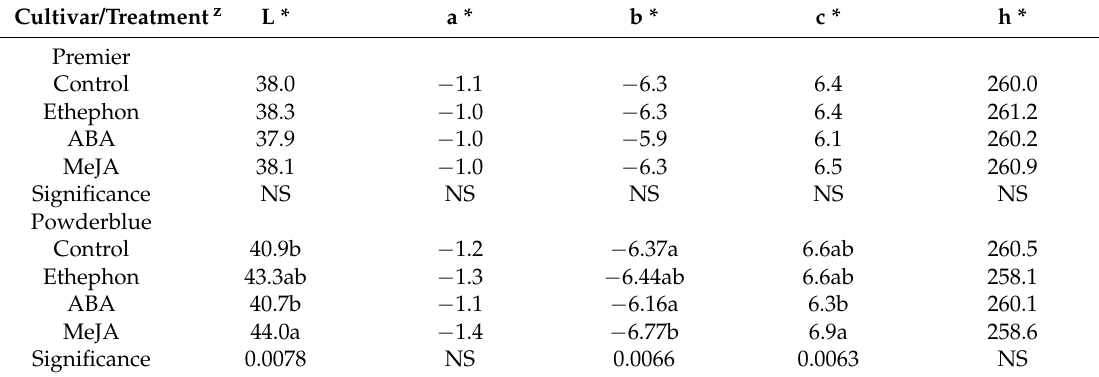
Table 1. Effect of preharvest treatment with water (control), ethephon, abscisic acid (ABA), and